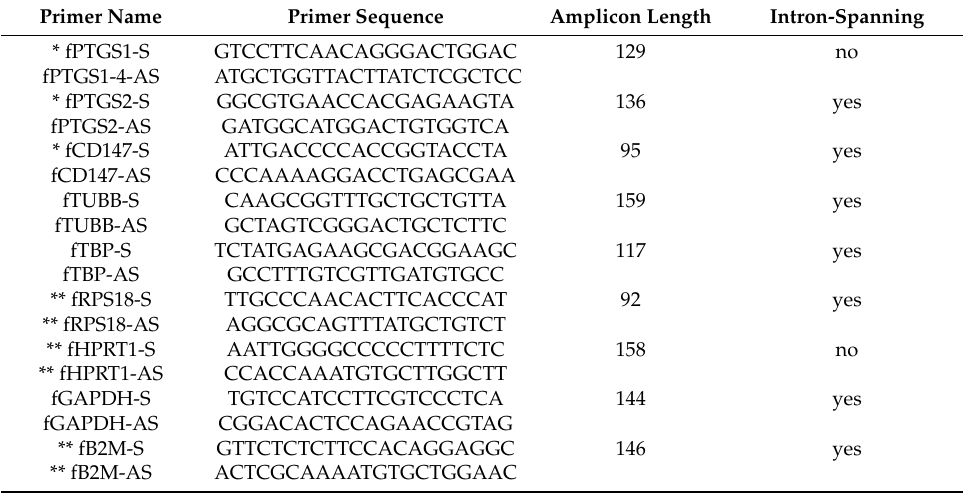
Table 3. RT-qPCR primers * Genes of interest: PTGS1 (COX-1), PTGS2 (COX-2), and CD147. ** Reference genes that were selected for normalization of the data after evaluation of M value (GeNorm M value) and CV value (coefficient of variation). Unmarked genes are candidate reference (housekeeping) genes that were tested but not